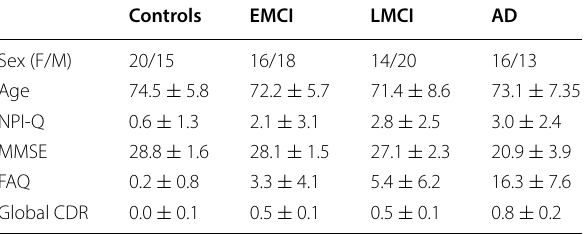
Table 1 Demographics and clinical